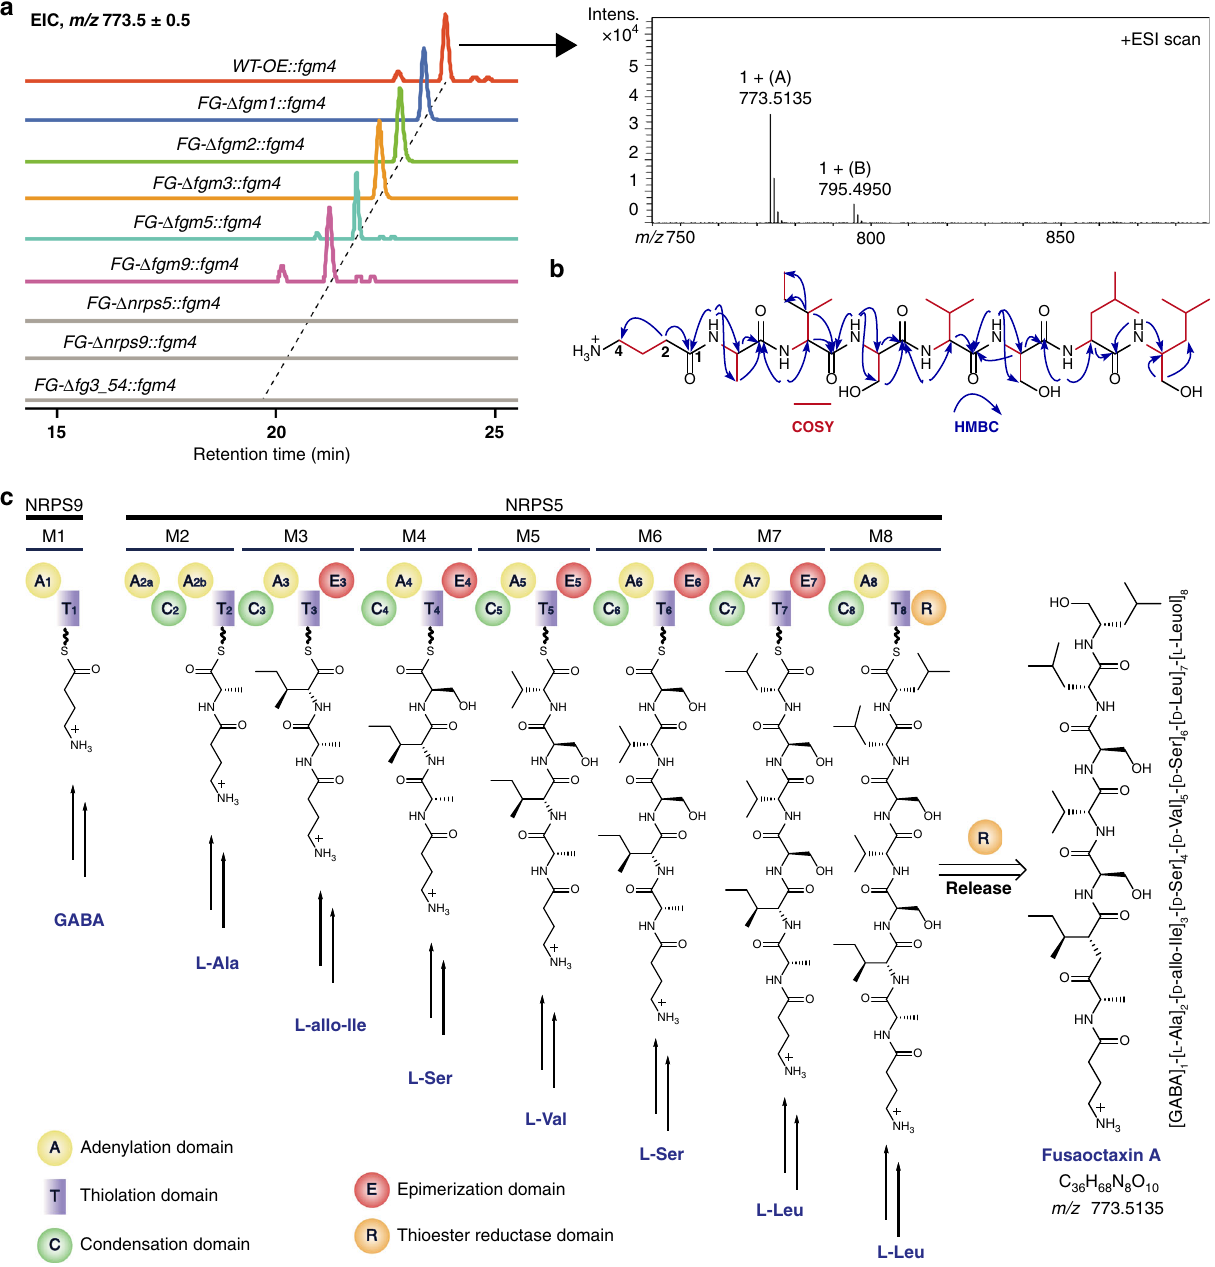
Fig. 4 Identi fi cation of fusaoctaxin A as the main product of fg3_54 . a Extracted ion chromatographic comparison of fusaoctaxin A production of the fgm4 - overexpressing derivatives of the indicated strains of F. graminearum . The electrospray ionization spectra of fusaoctaxin A are indicated in the frame. For HPLC – MS analysis, the ESI m/z [M + H] + mode for the extracted ion was 773.5 ± 0.5. b The planar structure of fusaoctaxin A elucidated by NMR spectra ( 1 H, 13 C, HSQC, 1 H- 1 H COSY, and HMBC). c Domain organization of non-ribosomal peptide synthetases and the biosynthetic route to fusaoctaxin A. NRPS5 and NRPS9, which constitute an assembly line programming the biosynthesis of fusaoctaxin A in a linear manner. The functional domains of NRPSs is indicated in color, including C (green), A (yellow), T (purple), E (red), and R